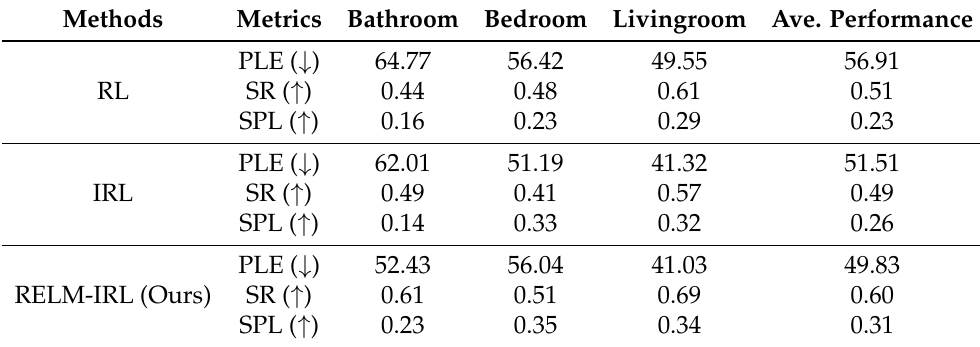
Table 2. Quantitative results for new targets in the same scenes in Task (II). The best results for individual scenes and the best average results across all scenes are shown in blue and red, respectively.